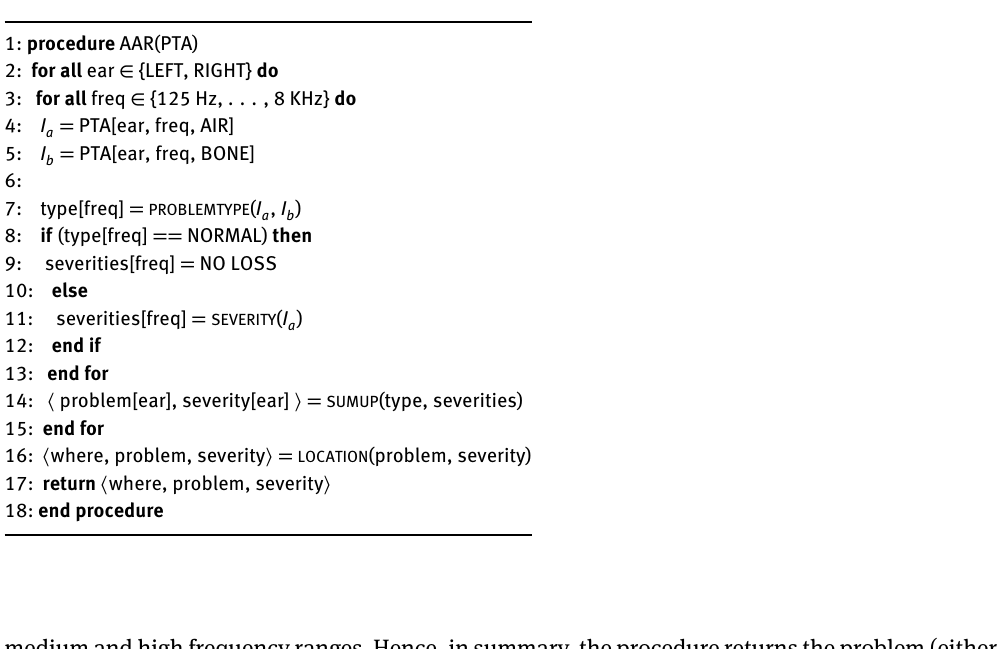
Figure 3: Air/bone conduction audiometry in the developed app. (a) An audiometry in progress where different pure tones are sent through the air/bone conductor at different frequencies and levels of loud- ness, and (b) the result is pro- videdintheformofanaudiogram with automated reporting.